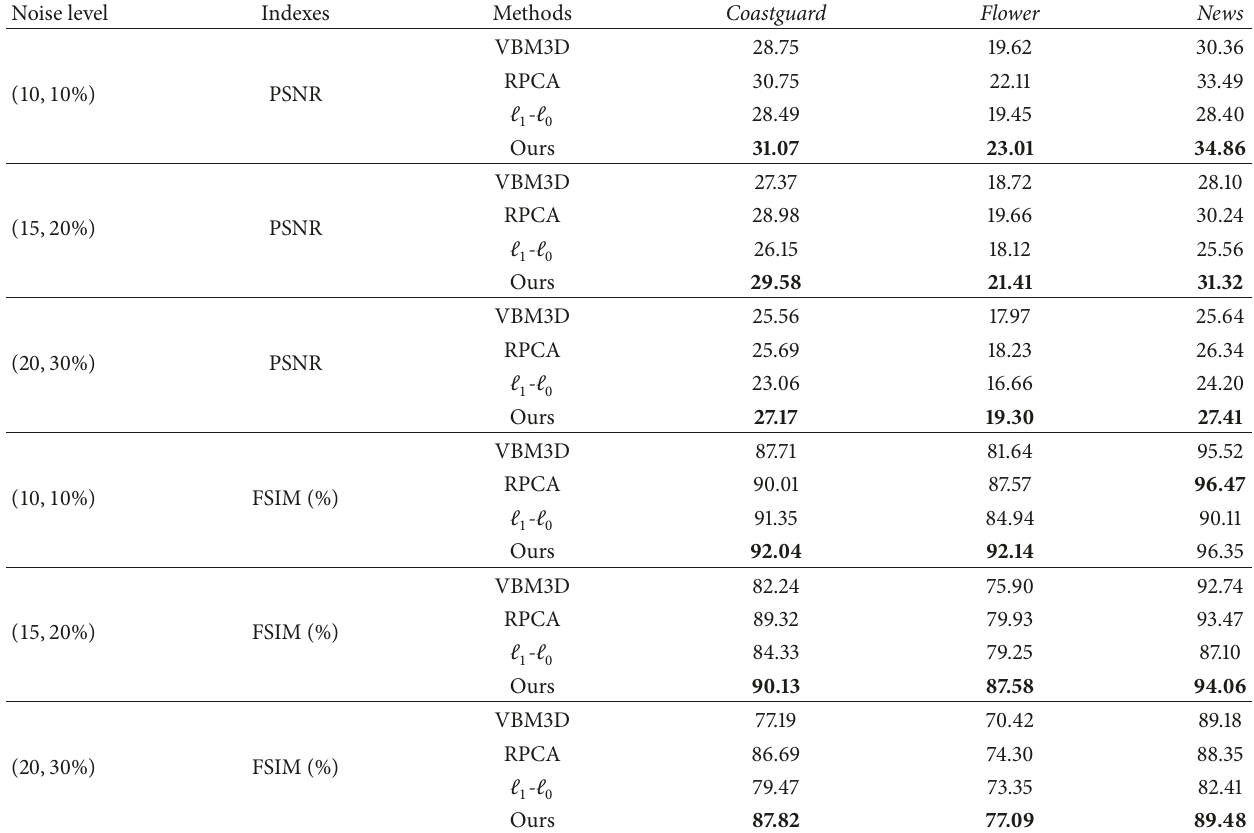
Table 1: Numerical results by the removal of MGRV, measured by PSNR and